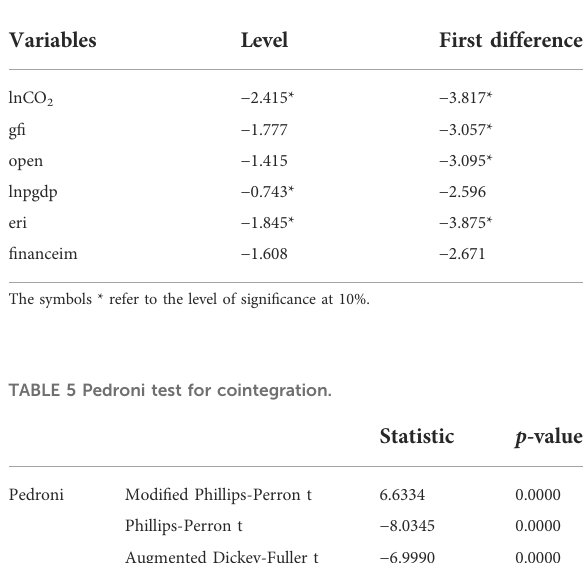
TABLE 4 Panel unit root test result.